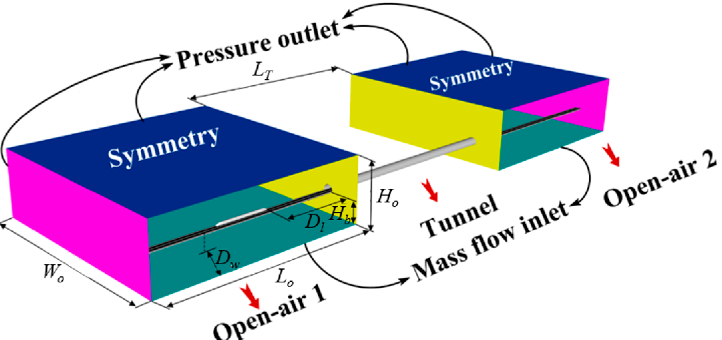
Figure 5. Computational domain (for Case 3). Figure 4. Computational domain (for Case Table 2. Dimensions of computational domain.